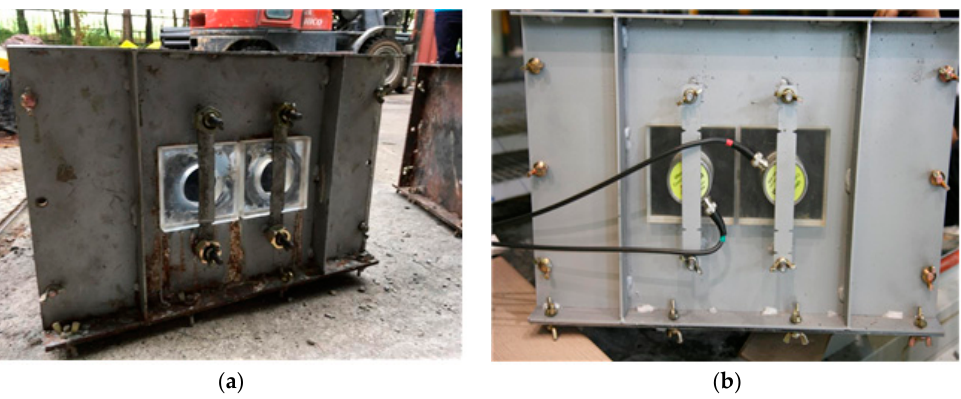
Figure 2. Preparation of the steel mold for surface wave velocity measurement: ( a ) mounting the acrylic panel within the steel mold before the installation of the ultrasonic transducer and ( b ) the steel mold after the installation of the ultrasonic transducer.